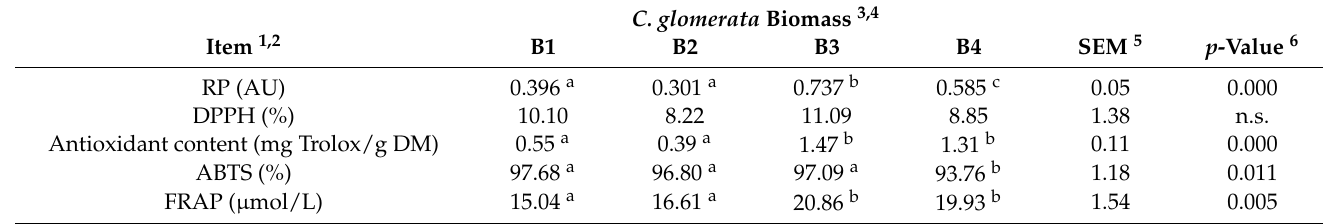
Table 3. Reducing power (RP), DPPH scavenging activity, antioxidant content, the relative ability of antioxidants to scavenge (ABTS) and ferric reducing-antioxidant power (FRAP) of C. glomerata biomass from various rivers in